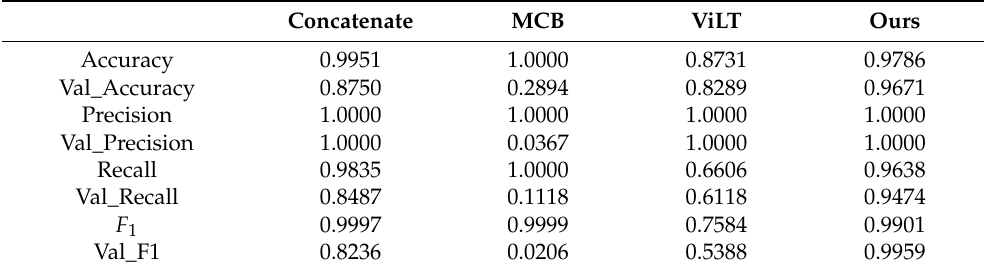
Figure 5. The algorithm’s classification results: ( a ) accuracy, ( b ) recall, and ( c ) F 1 score. Table 4. Comparative experimental results on the Clothes dataset. Note: Val_Accuracy, Val_Precision, Val_Recall, and Val_F1 are the accuracy, accuracy, recall, and F 1 score, respectively, for the valida- tion